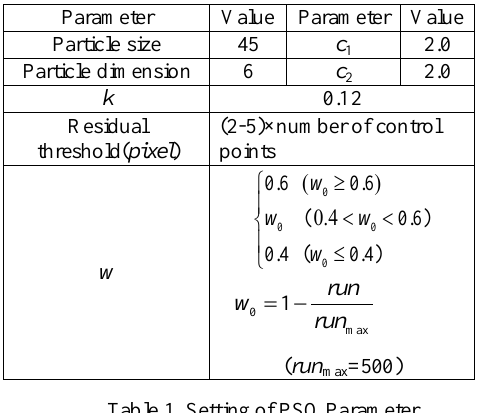
Table 1. Setting of PSO